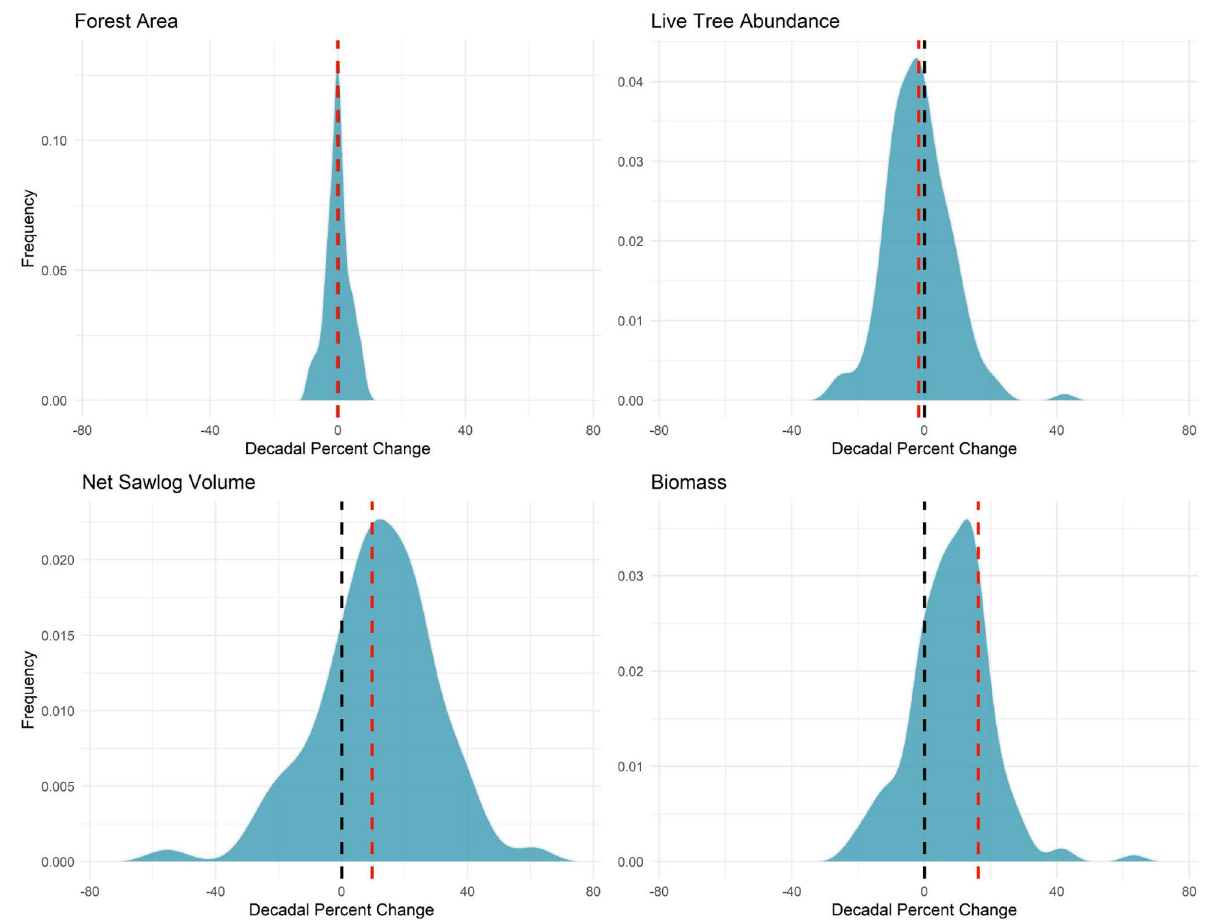
Figure 1. Percent change of forest attributes (forest land area, live tree abundance, net sawlog volume, and total live tree biomass) among coterminous US forest ecological sections, 1999–2012 to 2013–2020. Zero percent change indicated by dashed black line while mean percentage change indicated by dashed red line. Note : Ecological sections with minor amounts of forest that had potentially spurious decadal change ±10% removed from